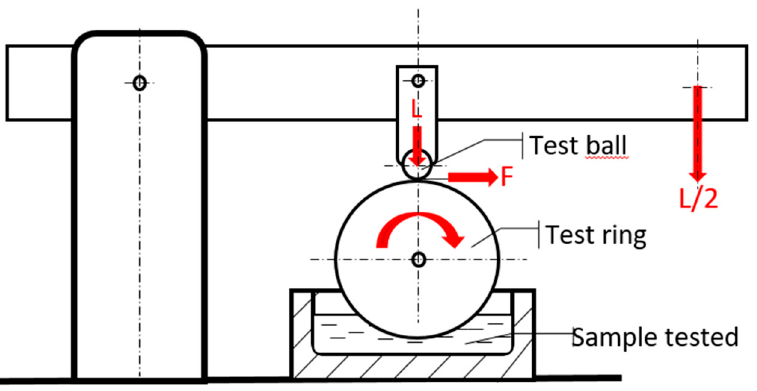
Figure 3. Schematic diagram of BOCLE, where L is the loading force, and F is the friction